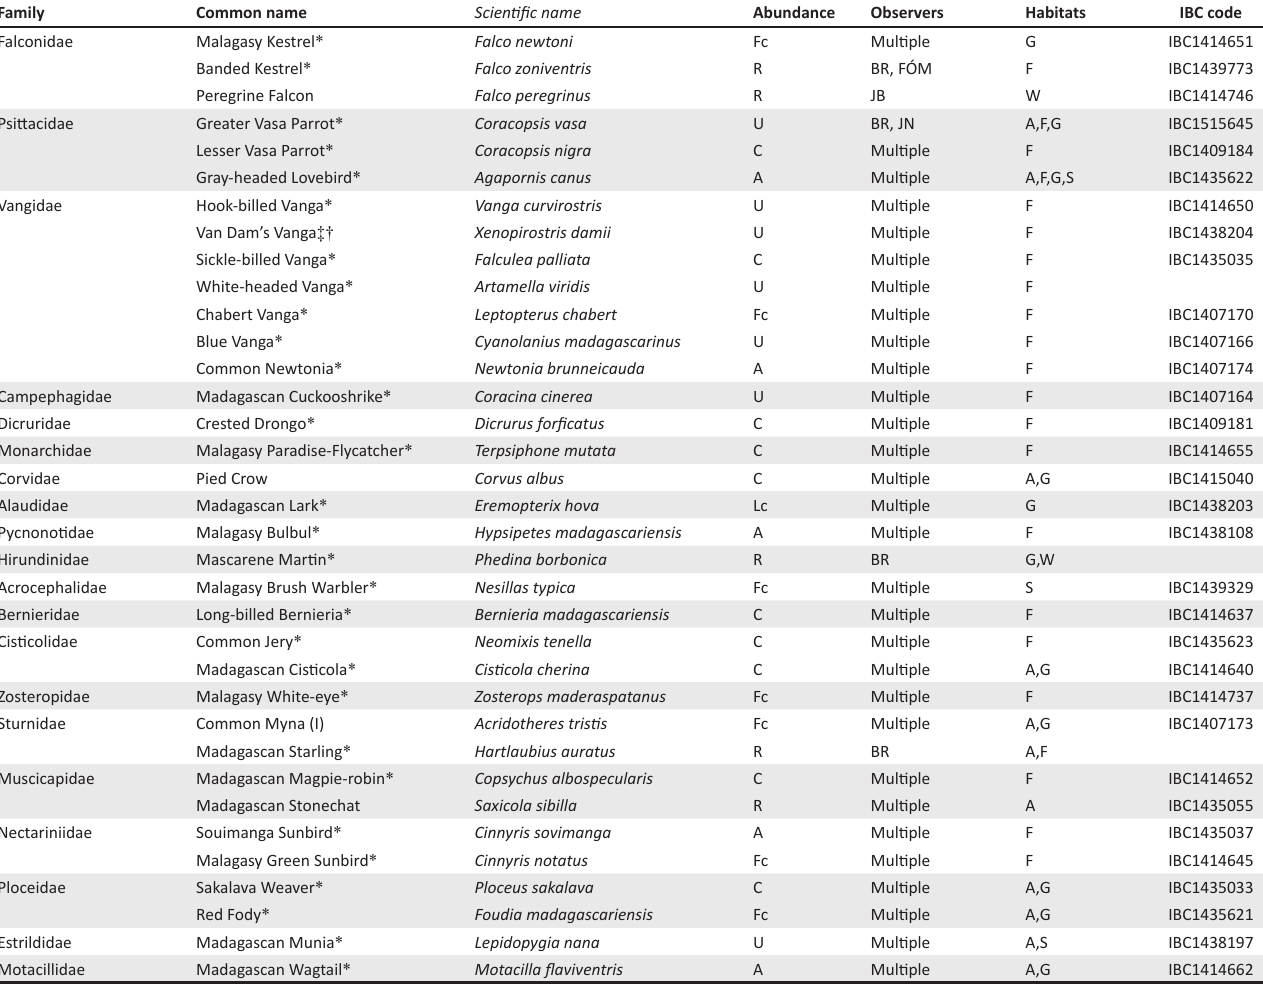
TABLE 1 (Continues...): Checklist of bird species recorded in Mariarano Forest and its vicinity between 2010 and 2018.